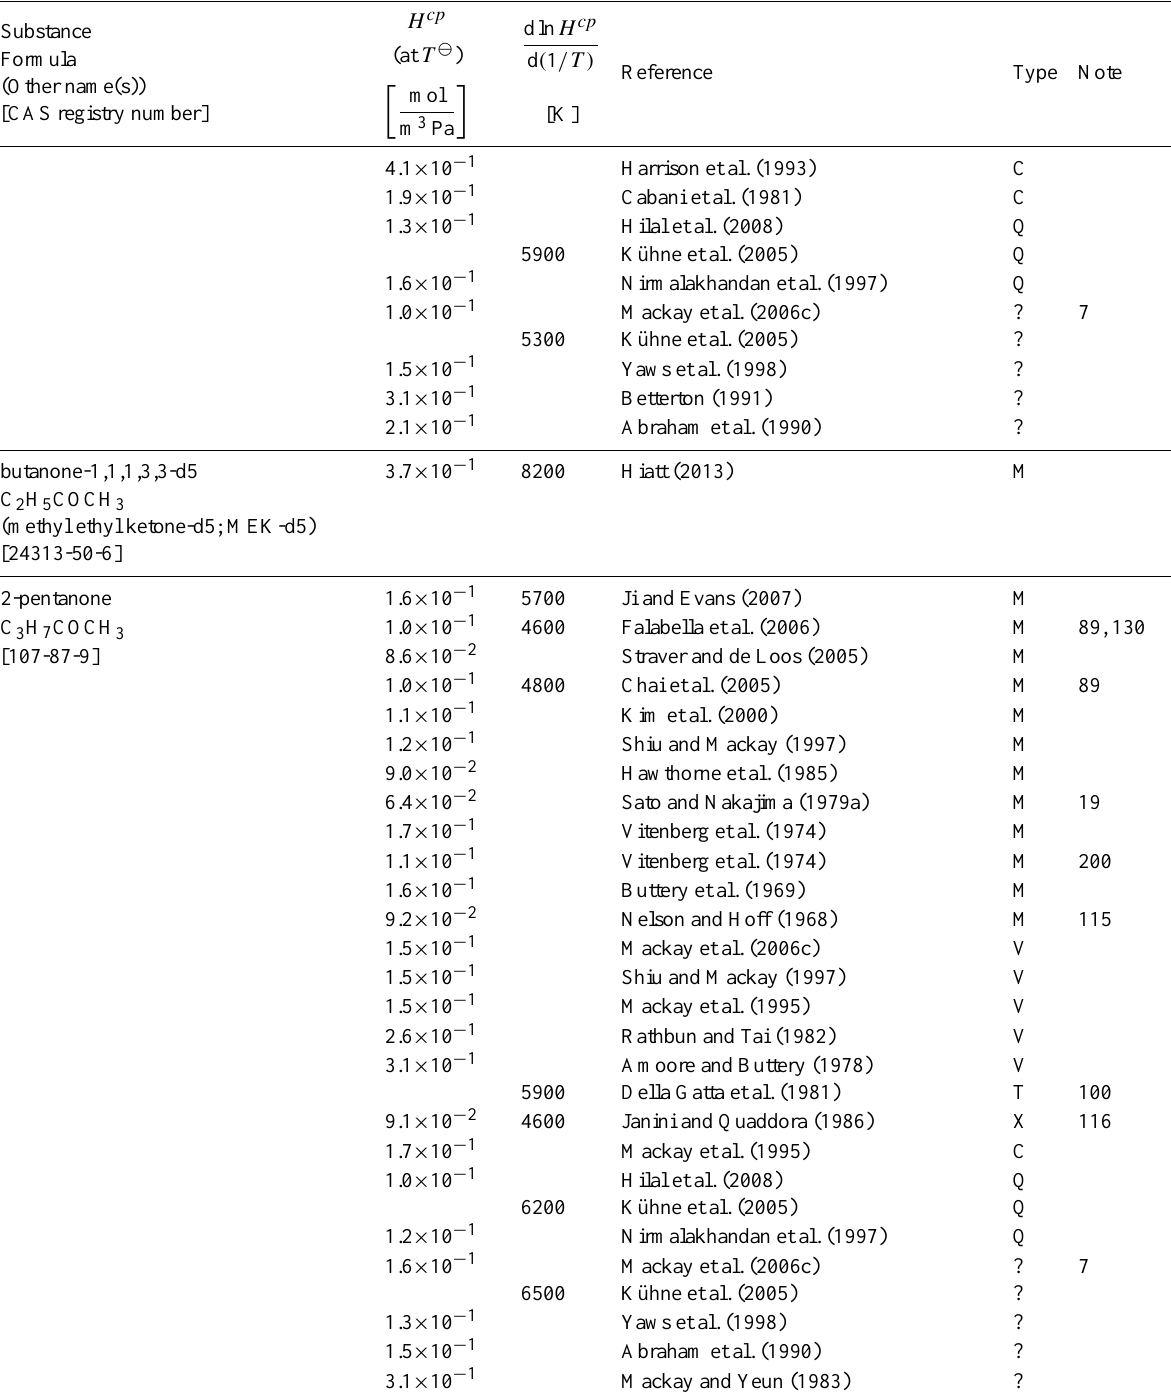
Table 6: Henry’s law constants for water as solvent